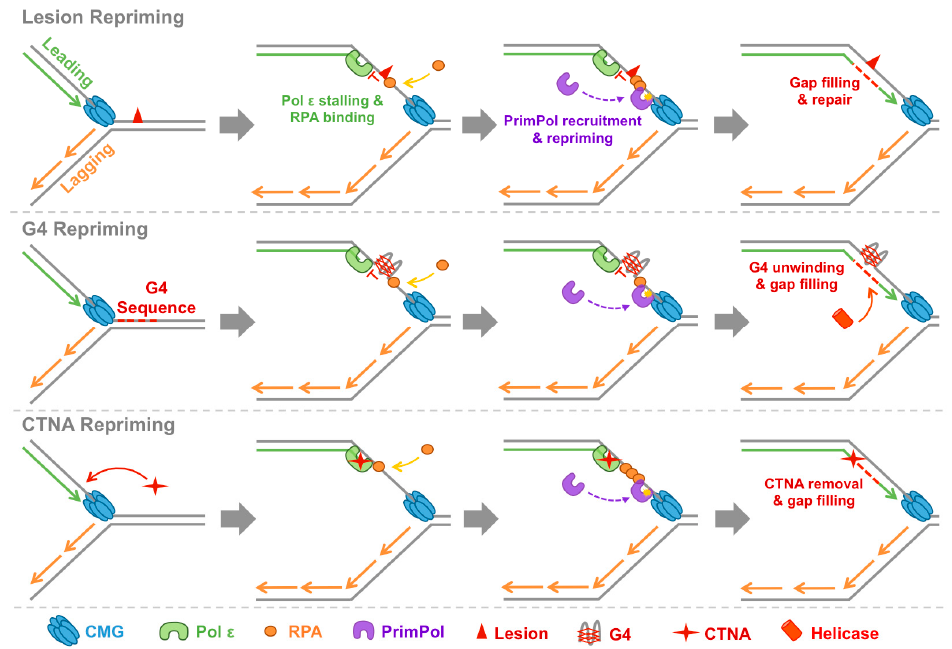
Figure 2. Repriming roles of PrimPol in nuclear DNA replication. PrimPol is able to reprime and reinitiate leading strand replication downstream of a range of replicase stalling obstacles. Here, the ability of PrimPol to reprime downstream of DNA lesions, G4 secondary structures, and chain-terminating nucleotide analogues, is highlighted. Following repriming, replication can proceed and the resulting single-stranded DNA (ssDNA) gap is filled through translesion synthesis (TLS) or template switching mechanisms, permitting subsequent repair or removal of the obstacle.